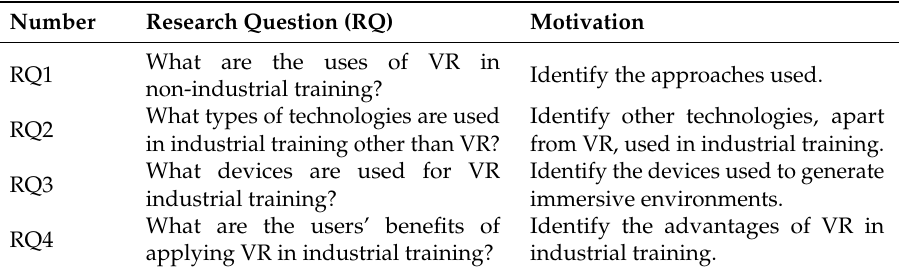
Table 1. Research